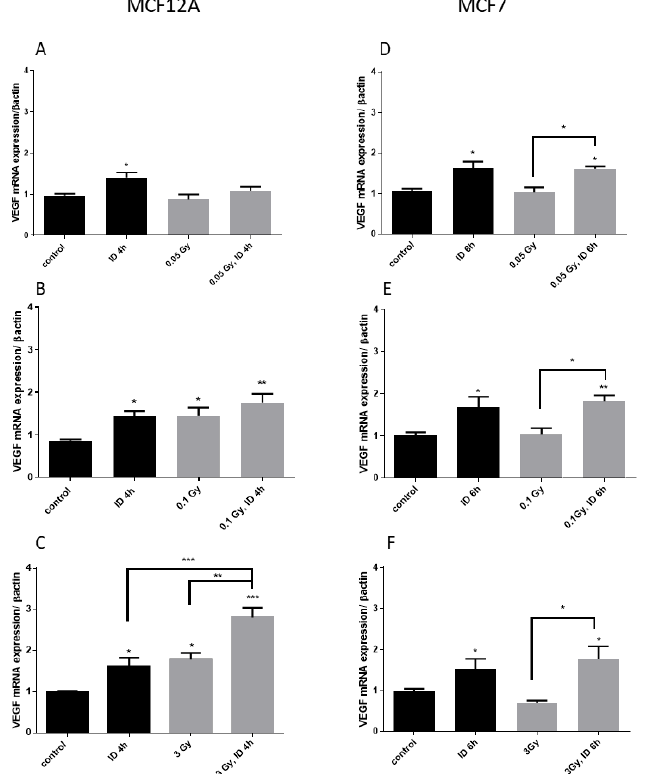
Figure 1. X-ray doses from 0.1 to 3 Gy increase vascular endothelial growth factor (VEGF) mRNA expression in MCF12A breast cells. MCF12A cells were cultured in iodine-containing medium for 7 days. Thereafter, the medium was replaced by fresh iodine-containing medium and cells were then irradiated with a dose of 0.05, 0.1, or 3 Gy. Cells were harvested 4 h after medium change. VEGF mRNA expression was determined using RT-qPCR. Data are expressed as means ± SEM. p -values < 0.05 were considered as statistically significant. * p < 0.05, ** p < 0.01. Statistical test: one-way ANOVA with Dunnett post-hoc test. N = 3, one representative experiment.